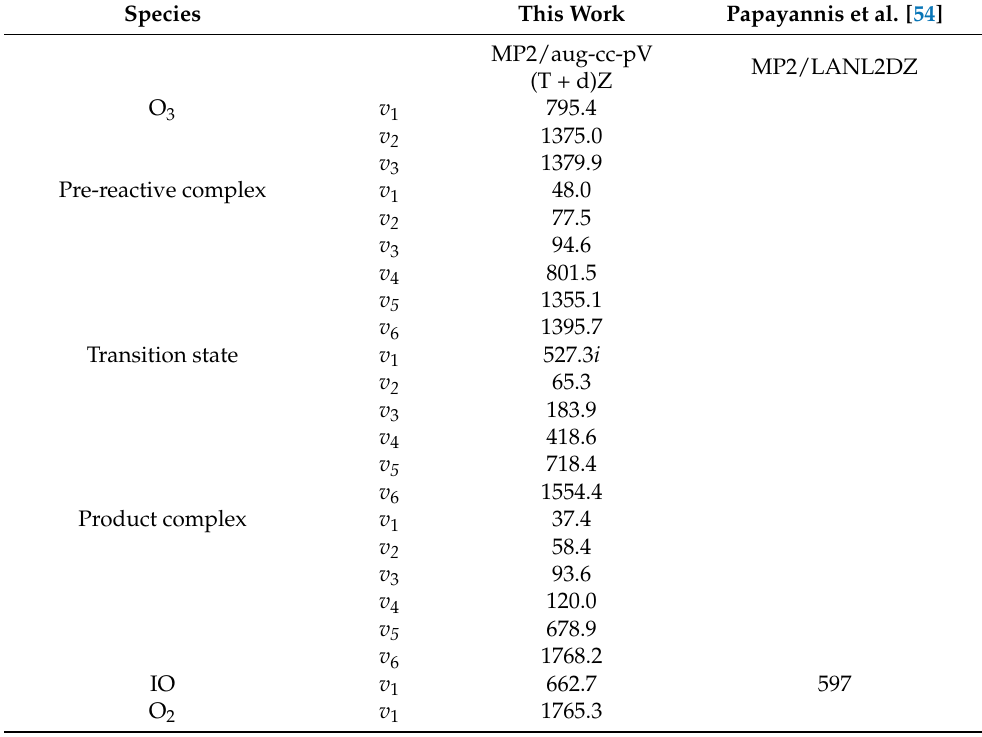
Table 8. Vibrational frequencies (cm − 1 ) for the reaction of I + O 3